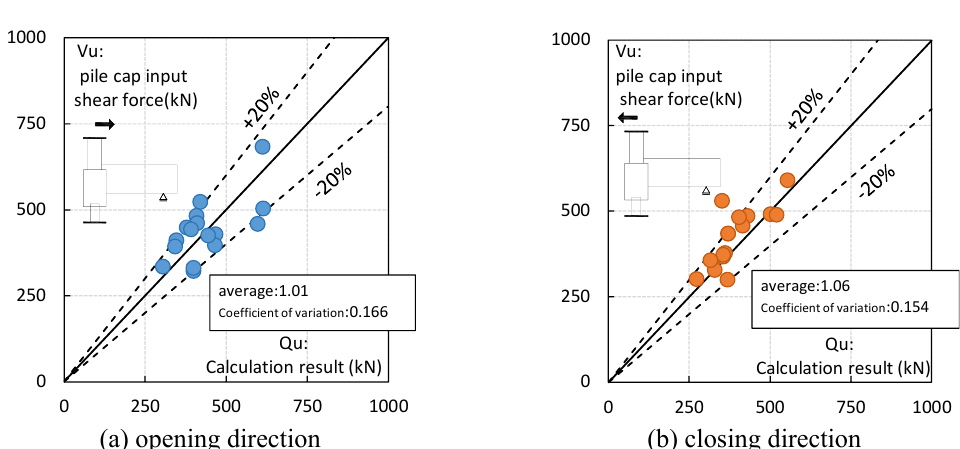
Figure 9. Relationship between experimental values and proposed